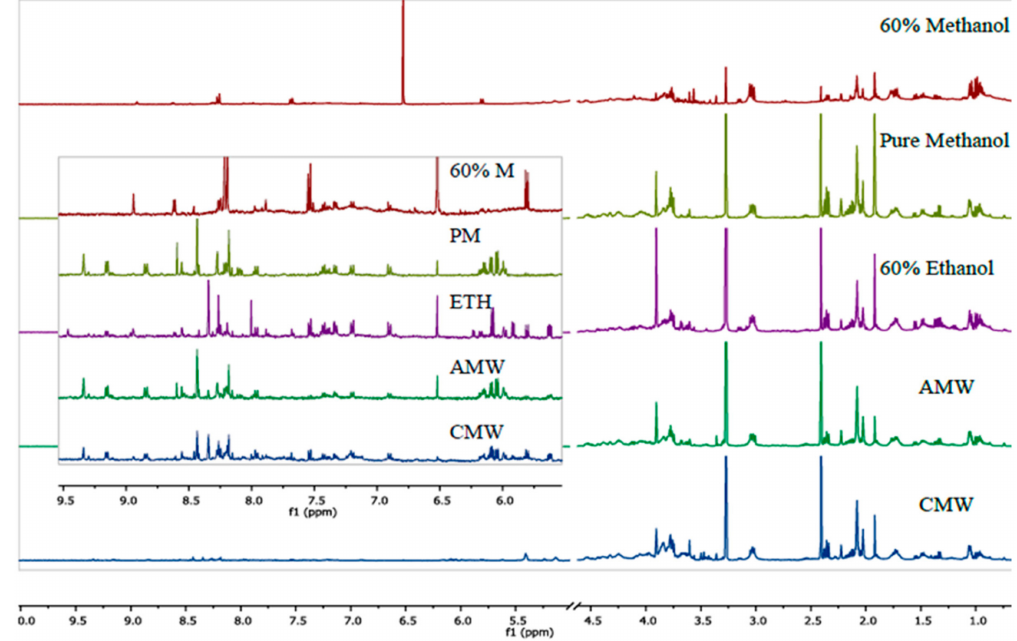
Figure 2. Representative 1 H-NMR spectra of the polar fraction of the metabolome of Y. pseudotuberculosis extracted using the tested extraction methods: 60% methanol, PM, 60% ETH, AMW; 2:2:1, and CMW;